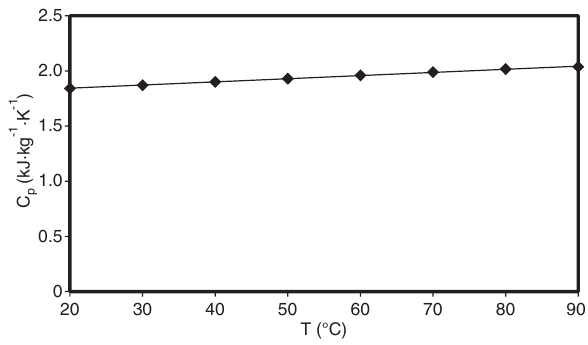
Figure 6 Heat capacity of